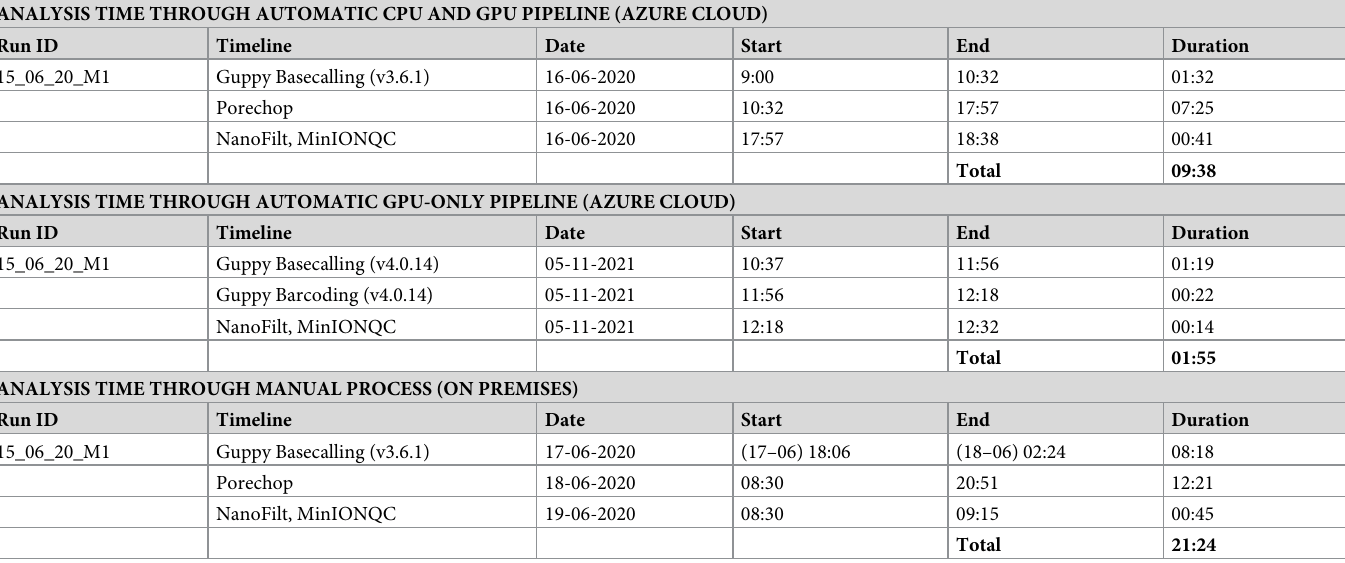
Table 4. Comparison of the running time required to complete the analysis for a MinION run between the automatic pipeline in the Azure cloud and the manual process onsite. ANALYSIS TIME THROUGH AUTOMATIC CPU AND GPU PIPELINE (AZURE